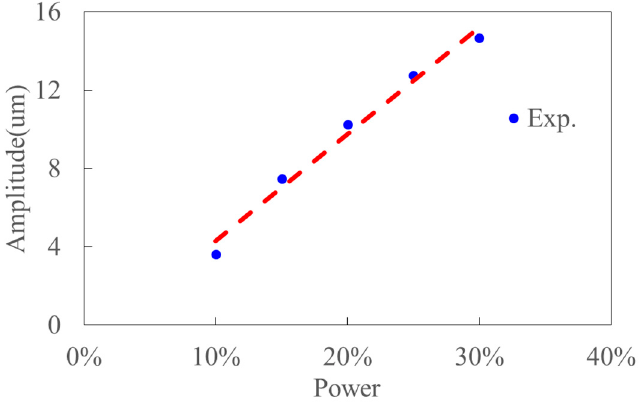
Figure 9. The variation of ultrasonic amplitude with power for ultrasonic vibration apparatus.